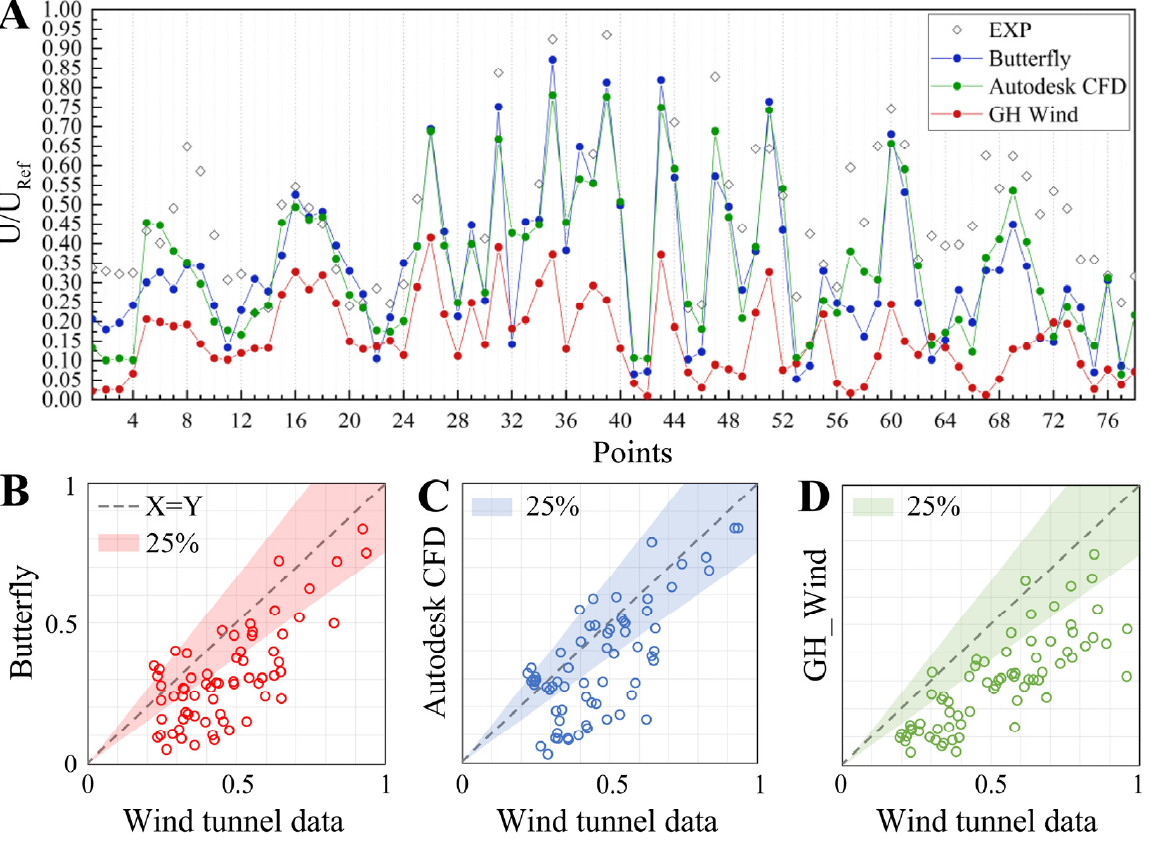
Figure 13. ( A ) The ratio of the wind velocity corresponding to the measured points on the horizontal plane of pedestrian level to the reference velocity (6.65 m/s) when the wind direction is 22.5°; correlation analysis of the simulation results obtained by ( B ) Butterfly, ( C ) Autodesk CFD, and ( D ) GH_Wind and wind tunnel data, respectively. Shaded regions in ( B – D ) mark the prediction envelopes with allowable errors of less than 25%.